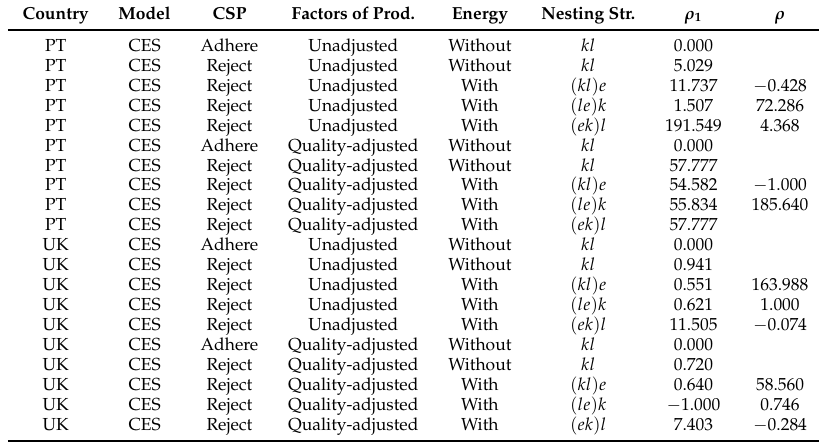
Table A3 shows estimated values of distribution parameters ( ρ 1 and ρ ) for all modeling approaches. Table A3. Elasticities of substitution ( ρ 1 and ρ ) for all modeling